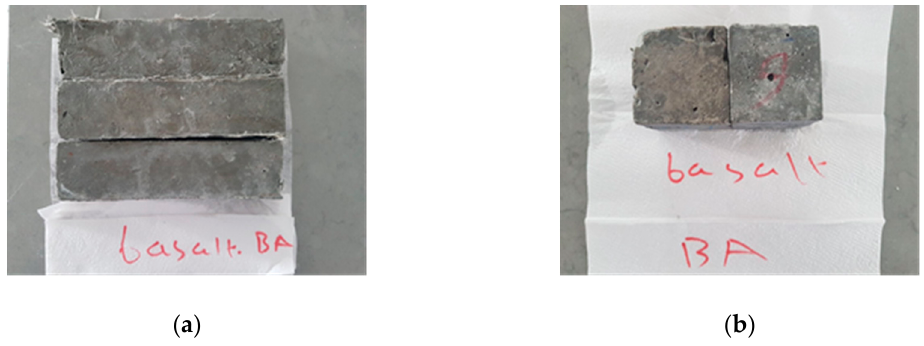
Figure 2. Basalt-fiber-enriched bottom ash composites: ( a ) flexural samples; ( b ) cubic samples.